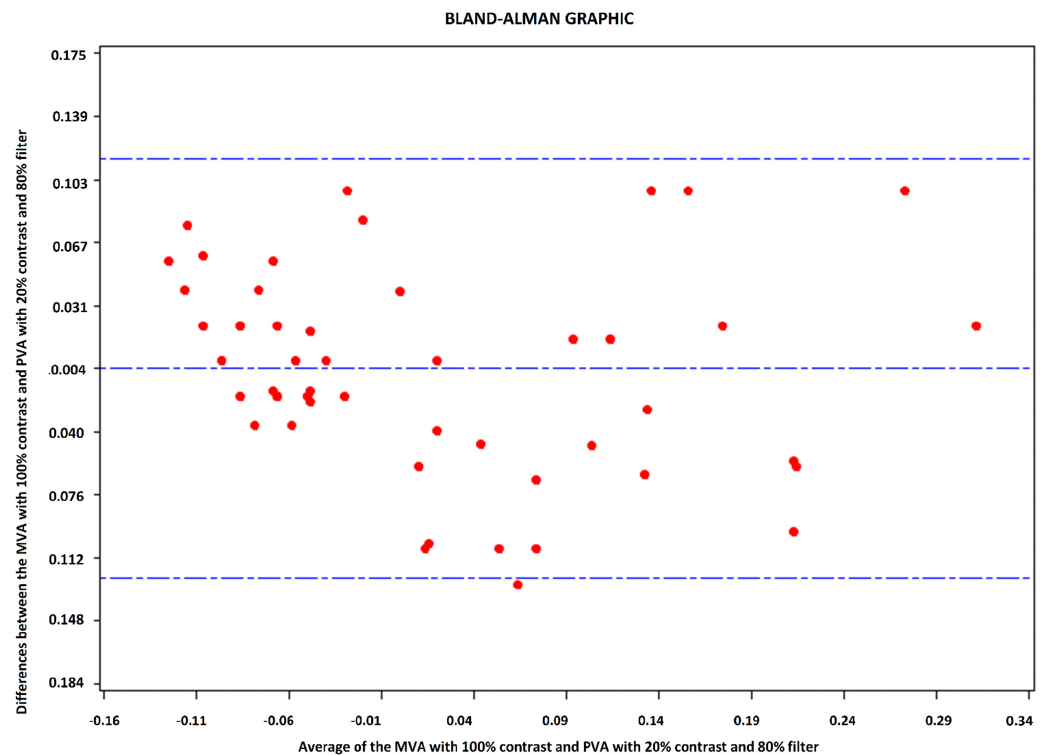
Figure 3. Bland–Altman plot of differences between the mesopic VA with 100% contrast and photopic VA with 20% contrast and a density filter of 80% absorption.